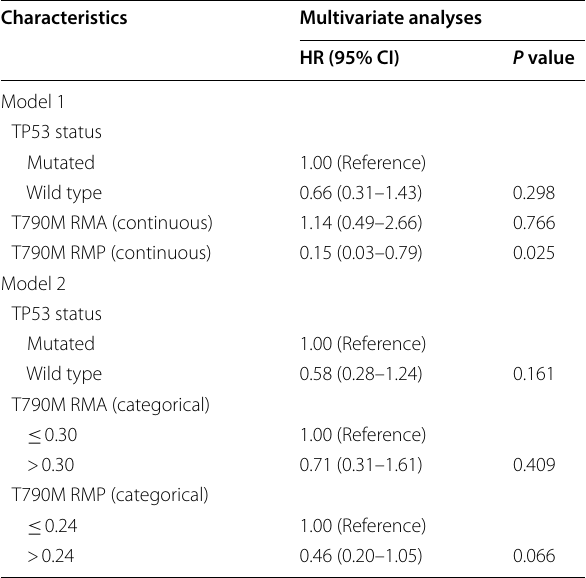
Table 3 Multivariate analysis for progression free survival in our